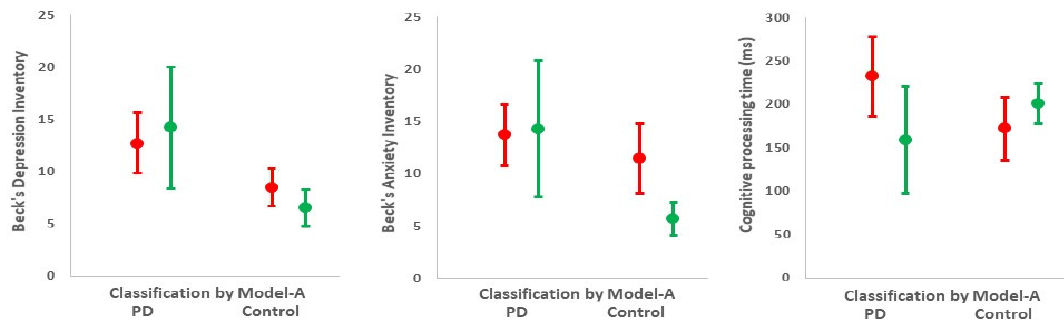
Figure 4. Psychometric phenotype according to subclassification by bowel function (Model A) in diagnosed PD group and in control group. Mean (95% CI) depression score, anxiety score, and cognitive processing time are shown for PD (red) and for controls (green). Of PD and control groups, 58% and 85%, respectively, were correctly allocated by bowel function, whilst 42% and 15% were allocated incorrectly.